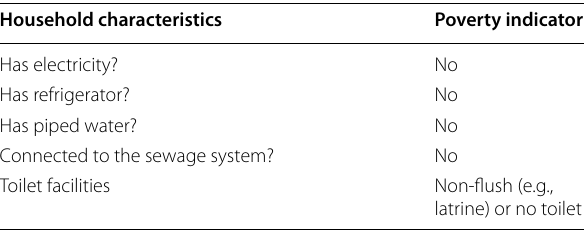
Table 1 Household characteristics used in the poverty index Household